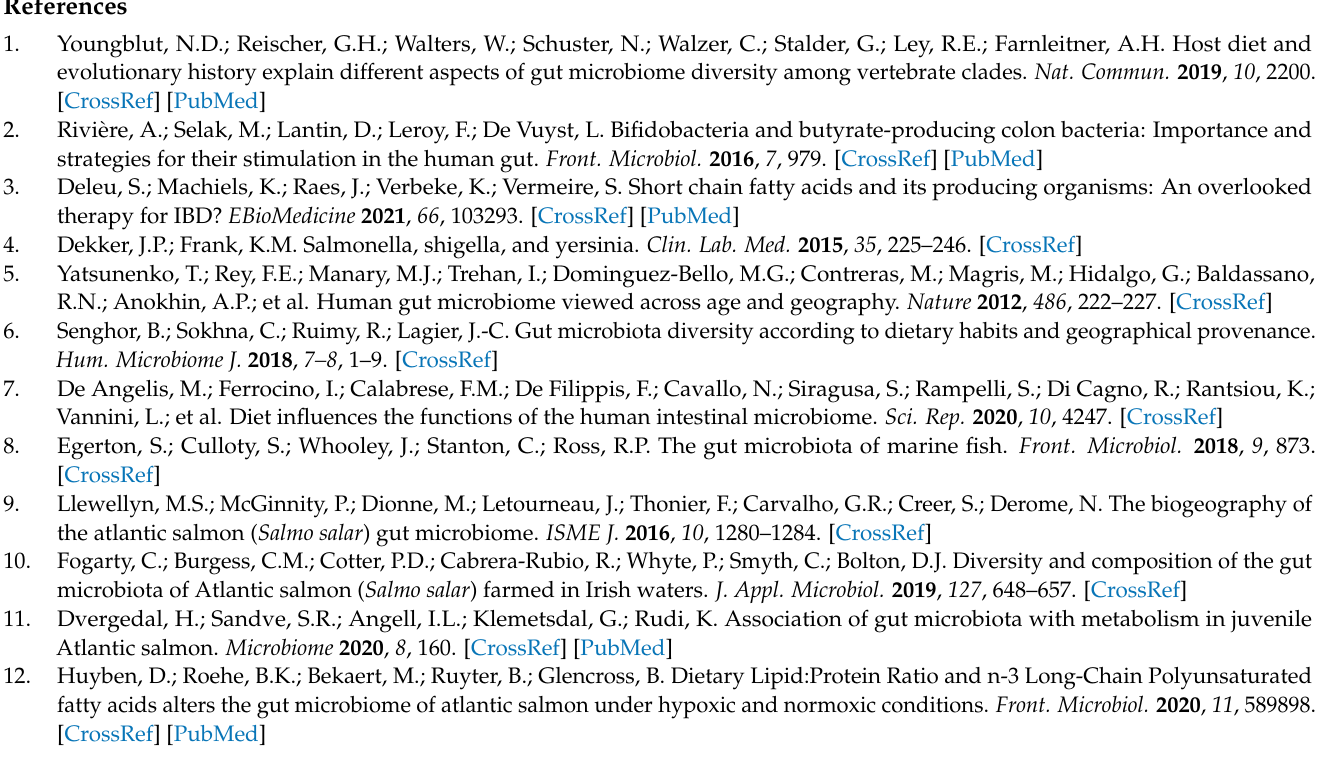
Figure S1: Photograph of a defrosted mackerel icefish, Champsocephalus gunnari ; Figure S2: The use of spreaders for squeezing out the intestinal contents from the wall; Figure S3: Non-matric multidimen- sional plot based on the Bray–Curtis dissimilarity between samples. Samples are grouped by sex; Figure S4. Phylum composition of the C. gunnari gut microbiome. WI: whole intestine; IW: intestinal wall; IC: intestinal